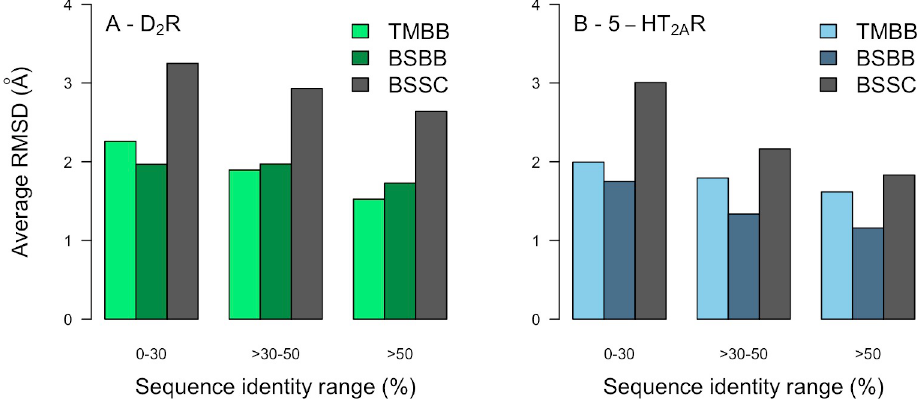
Fig 1. Structural accuracy of homology models based on templates with different levels of sequence identity. The average RMSD TMBB (green and blue bars), RMSD BSBB (dark green and blue bars), and RMSD BSSC (grey bars) to the crystal structures were calculated for 50 models per template. Bar charts of structural accuracy using templates with different levels of sequence identity was calculated for (A) the D 2 R and (B) 5-HT 2A